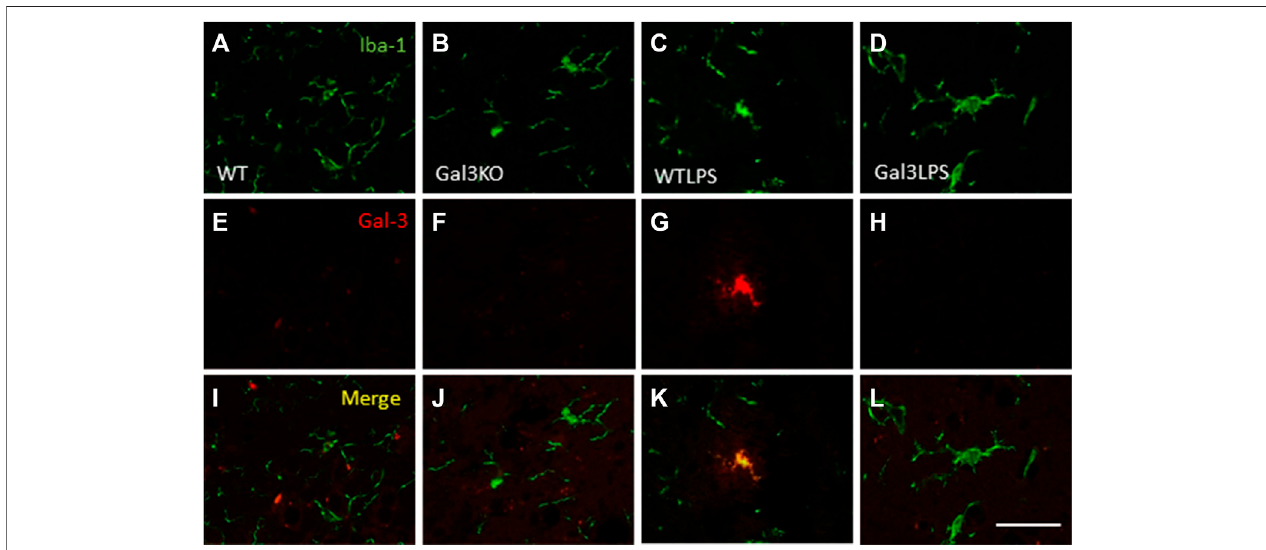
FIGURE 5 | Expression of Gal3 in LPS-activated microglia. Representative images from sections of the different treatments assayed showing immunostaining of Iba1 (green) and Gal3 (red). Only a few Iba1 positive cells co-localized with Gal3 (yellow) in animales WT treated with LPS (K), indicating a not possible DAM phenotype. Scale bar: 75 μ m. Abbreviations: WT, wild type mice; WTLPS, wild type mice treated with LPS; Gal3KO, Gal3 knockout mice; Gal3KOLPS, Gal3 knockout mice treated with